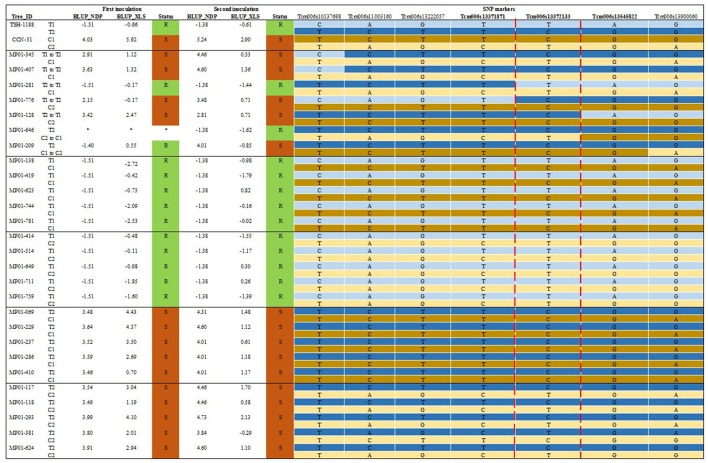
Haplotype combination analysis in the MP01 parents, recombinant trees plus the resistant (R) and susceptible (S) trees. Maternal and paternal haplotypes are shown at the top of the figure. The asterisk (*) means that the tree was not evaluated. Hap is the abbreviation of haplotype. The red dash line shows the smallest chromosomic region from T1 associated with resistance. The three main SNP marker are highlighted in bold.